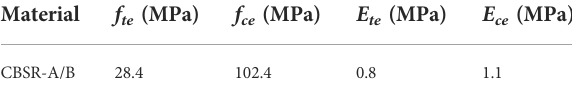
TABLE 5 Mechanical properties of epoxy